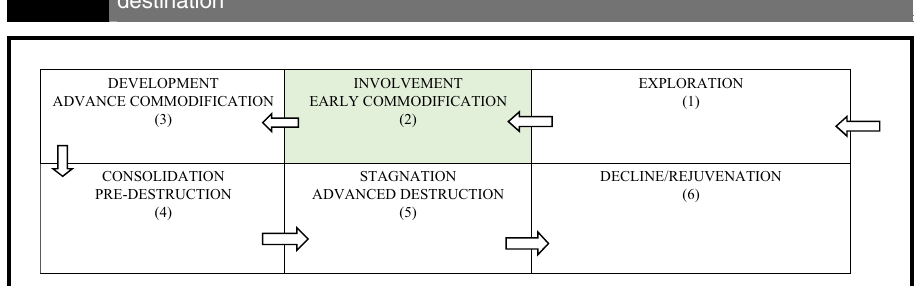
Figure 1 Matrix of tourism development in a post-colonial, post-conflict and